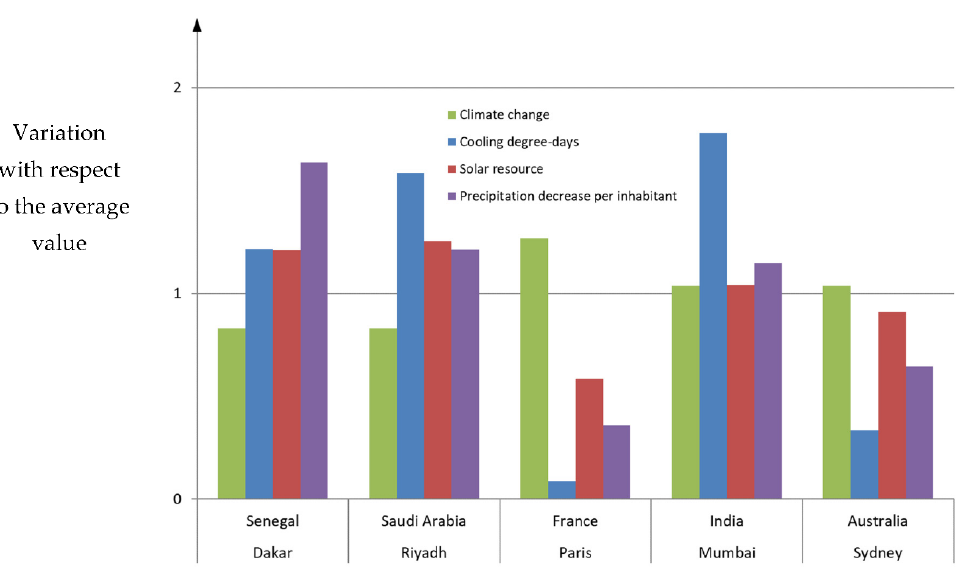
Figure 14. Relationship between relative values of climate change, cooling degree days, solar resource and precipitation decrease per inhabitant of five